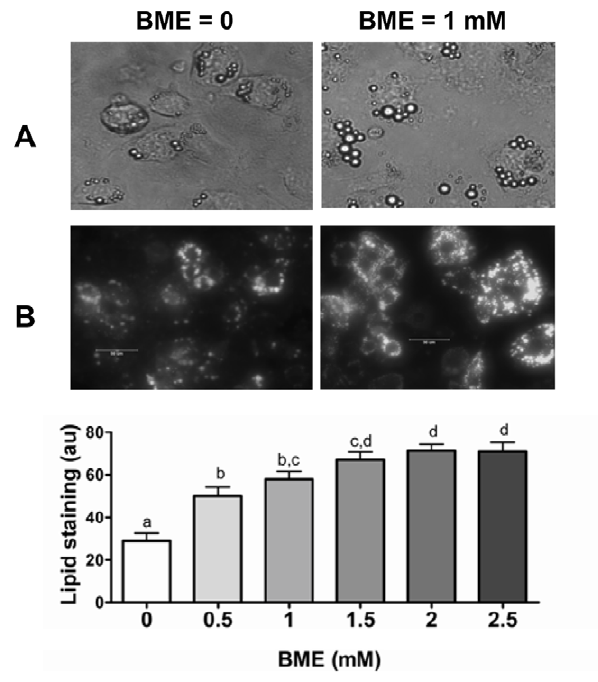
Figure 1. BME increases lipid accumulation in F442A cells . A : microphotograph of cells treated with control (left panel) and BME (1 mM, right panel) on day 6 after cells were induced to differentiated by insulin supplement. B : fluorescent microphotograph of cells after staining with BODIPY-C12 under otherwise the same conditions as those shown in A. bar=5 6 10 2 5 m. C : quantitative fluorescent intensity of lipid staining on day 6. Results are mean + / 2 se from four independent cell cultures for each five different views were analyzed. Columns denoted with non-identical alphabets are statistically different (p , 0.05, by Tukey’s test).